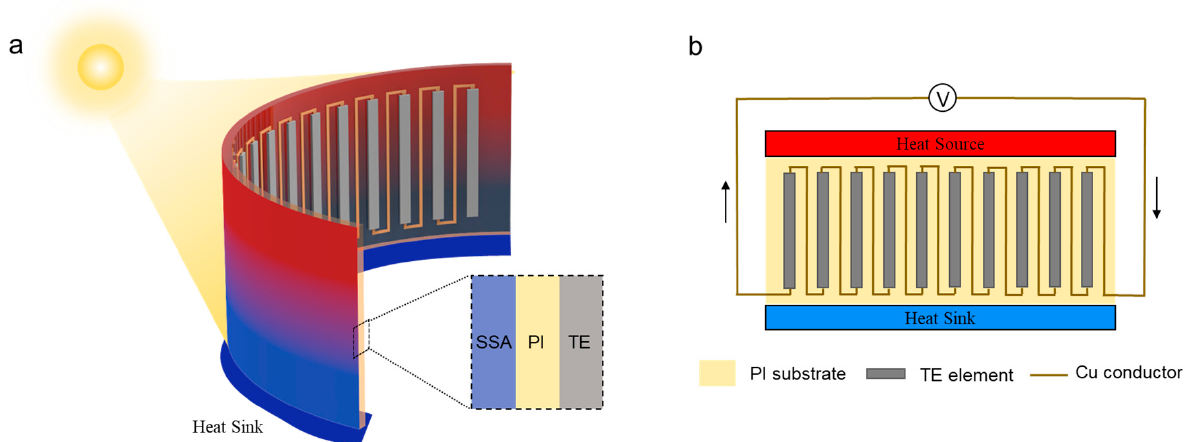
Figure 1. Structure and principle of the thin-film solar thermoelectric generator. ( a ) Schematic diagram of the thermal concentration solar thermoelectric generator. SSA, PI, and TE represent the spectral-selective absorber coating, polyimide (PI) film and Bi 2 Te 3 thermoelectric layer. ( b ) Designs of thermoelectric energy conversion module.